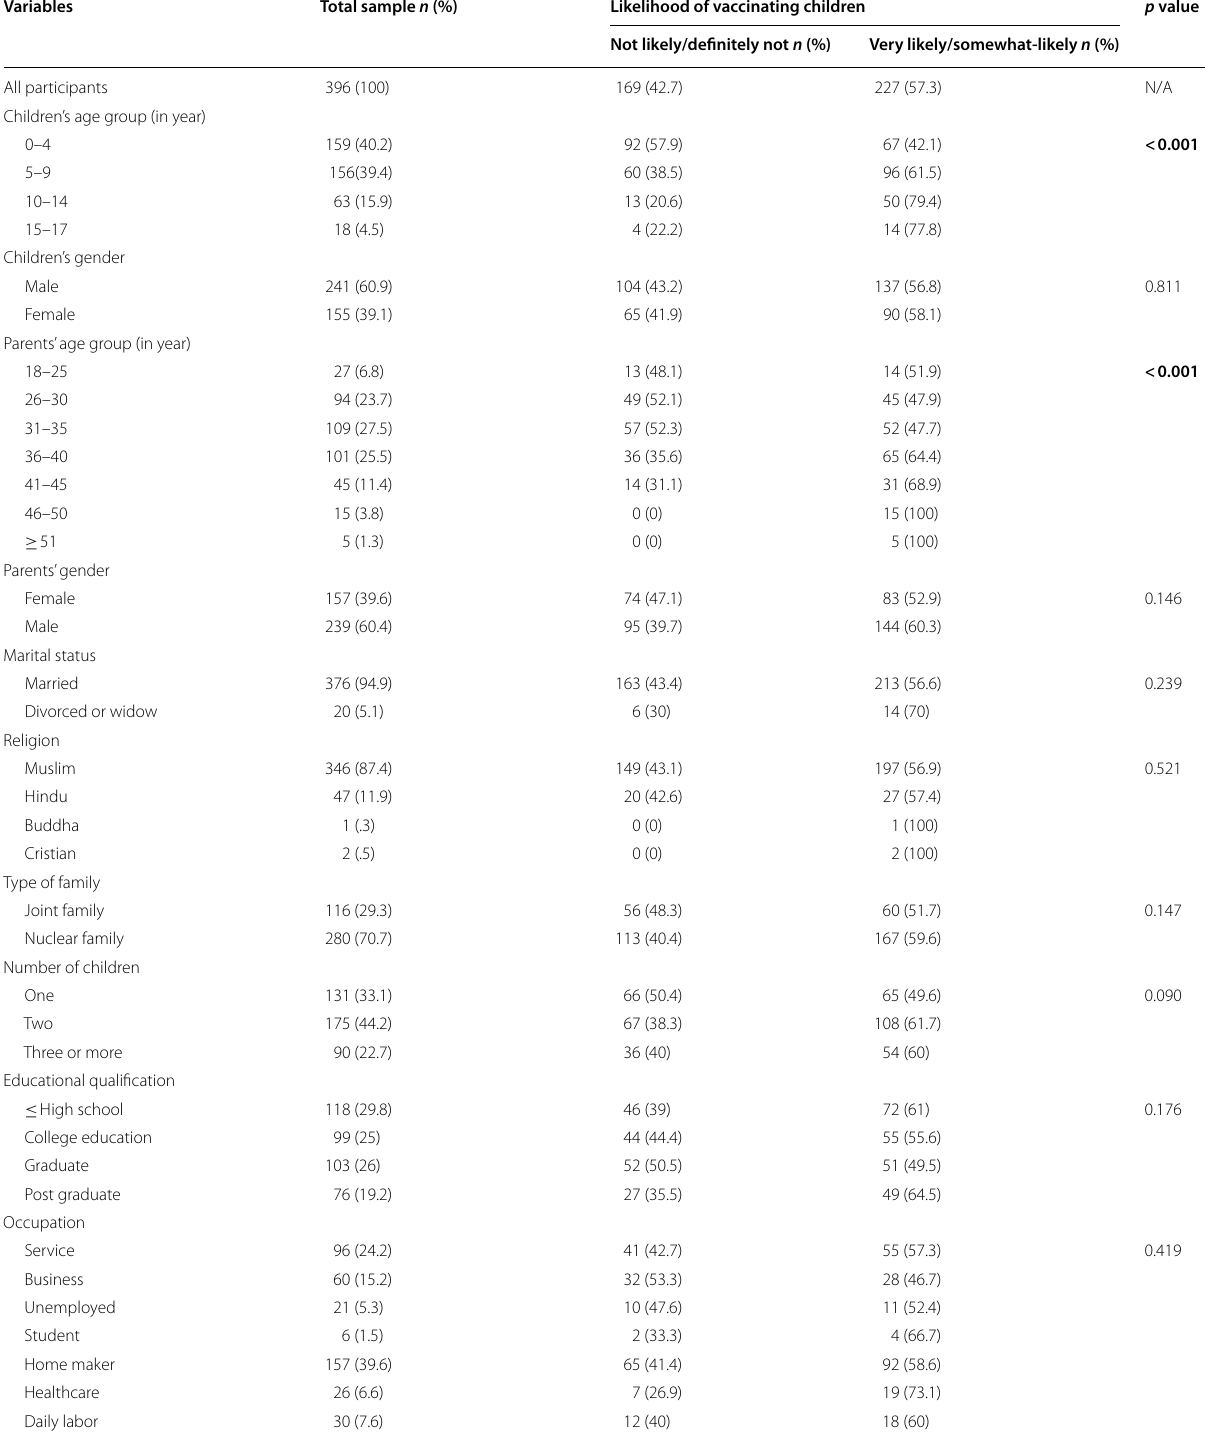
Table 1 Descriptive analysis: sociodemographic characteristics, COVID‑19 threat, and parental vaccine hesitancy